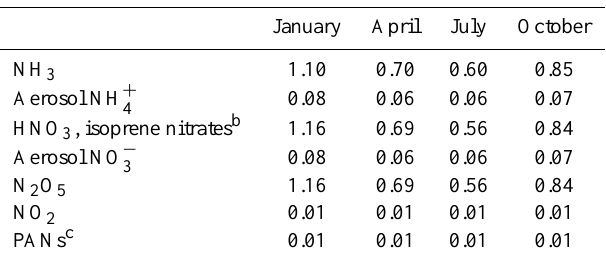
Table 1. Monthly mean daytime dry deposition velocities over the northwestern Pacific a